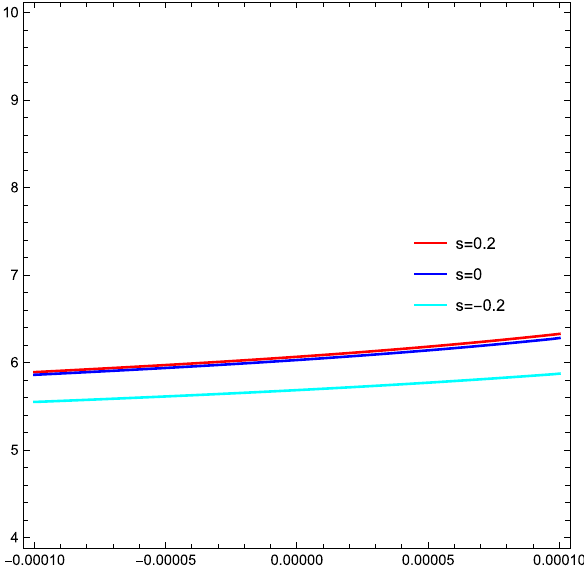
Fig. 8 ISCO radius in term of L , for counter-rotating test body with a / M = 0 . 01